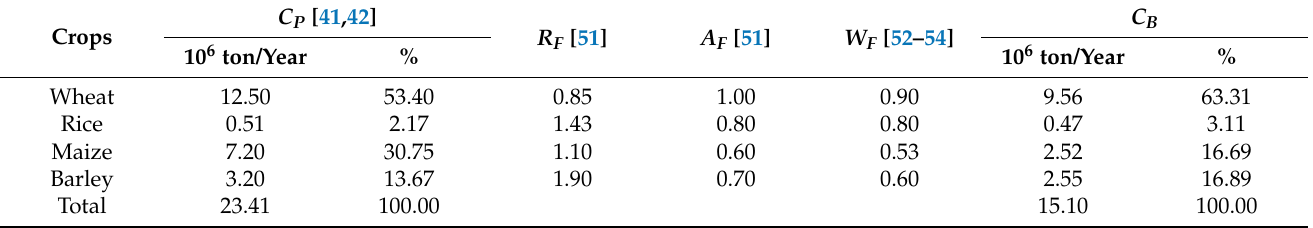
Table 1. Calculated collectible dry biomass ( C B ) from crop residues available in